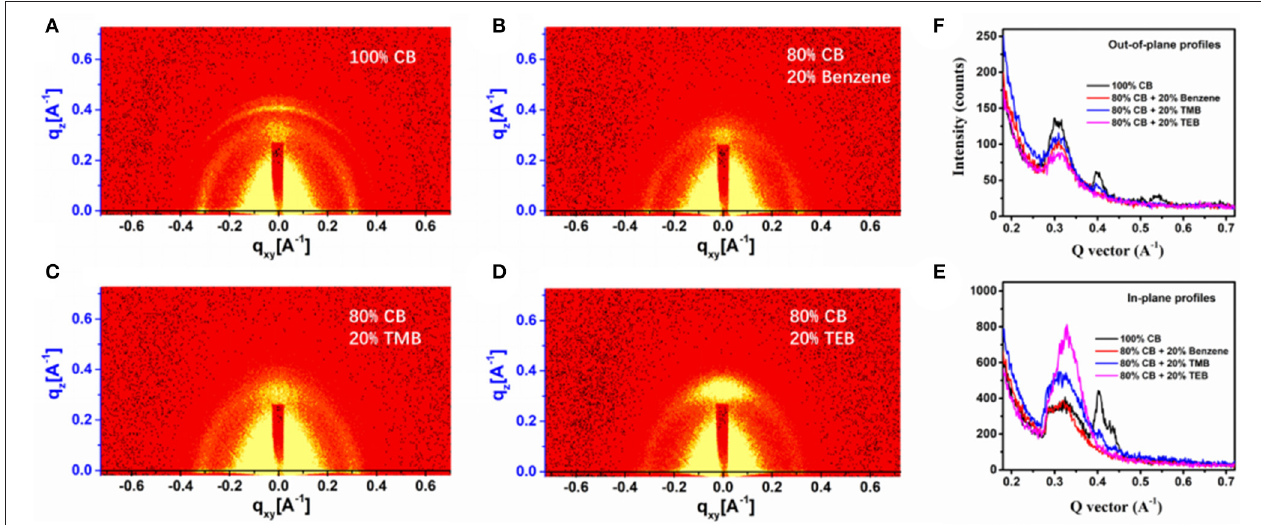
FIGURE 3 | Grazing incidence wide-angle X-ray scattering (GIWAXS) images of the films prepared using (A) 100% CB, (B) 80% CB + 20% benzene, (C) 80% CB + 20% TMB, and (D) 80% CB + 0% TEB; (E) out-of-plane and (F) in-plane GIWAXS profiles for devices using varied